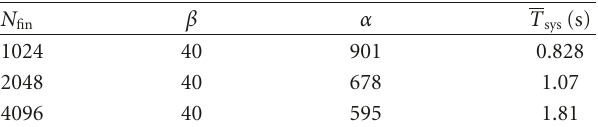
Table 3: T sys versus N fin .